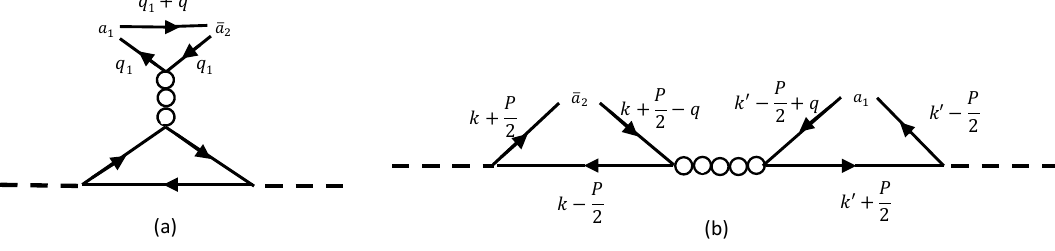
Figure 5 . Other possible diagrams in the NJL model. All of them do not contribute to the dPDFs, as explained in the